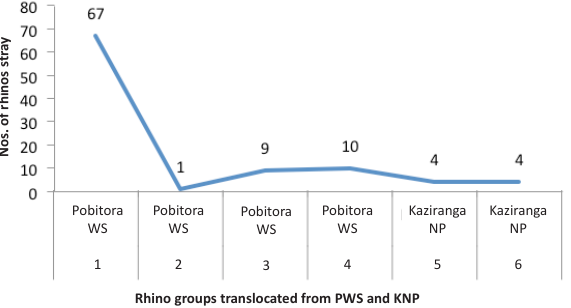
Figure 14. Pobitora Wildlife Sanctuary and Kaziranga National Park rhinos’ stray occurrences after being released at Manas National Park